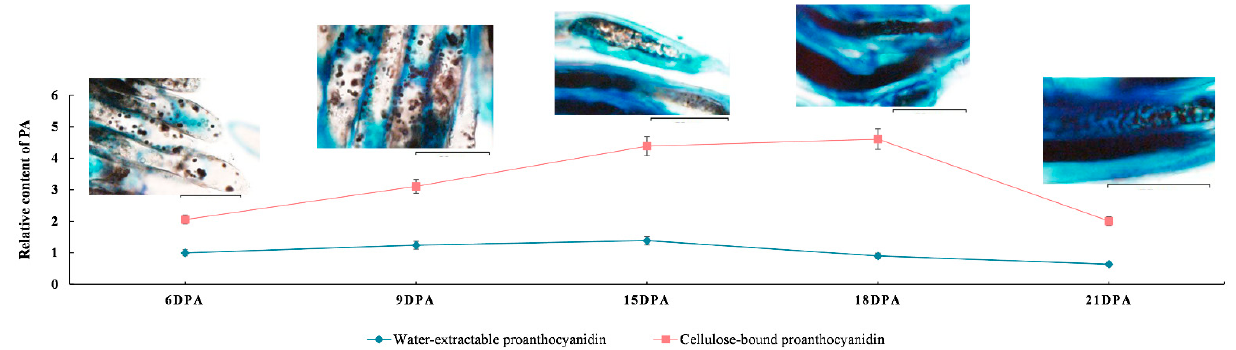
Figure 2. Accumulation of proanthocyanidins (PAs) during fiber development in Gossypium stocksii (6–21 DPA). The TBO staining was performed to observe the accumulated PAs using the fibers from the same days as colorimetrical analyses (scale bar: 20 µm).